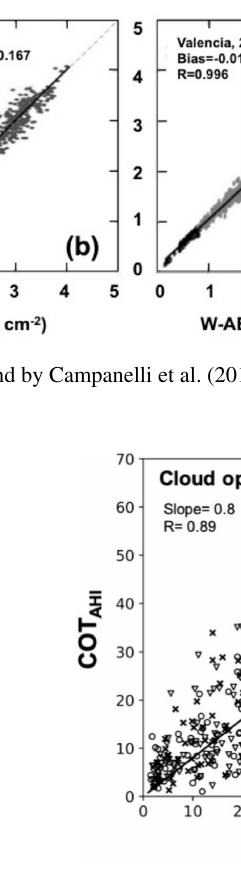
Figure 13. Comparison of cloud optical thickness (COT) retrieved from sky radiometer at the Chiba, Fukue, and Hedo sites and the Himawari-8/AHI satellite-borne imager in the period of October 2015 to December 2016 (Khatri et al., 2019). The regression line is shown with zero intercept constraint at the